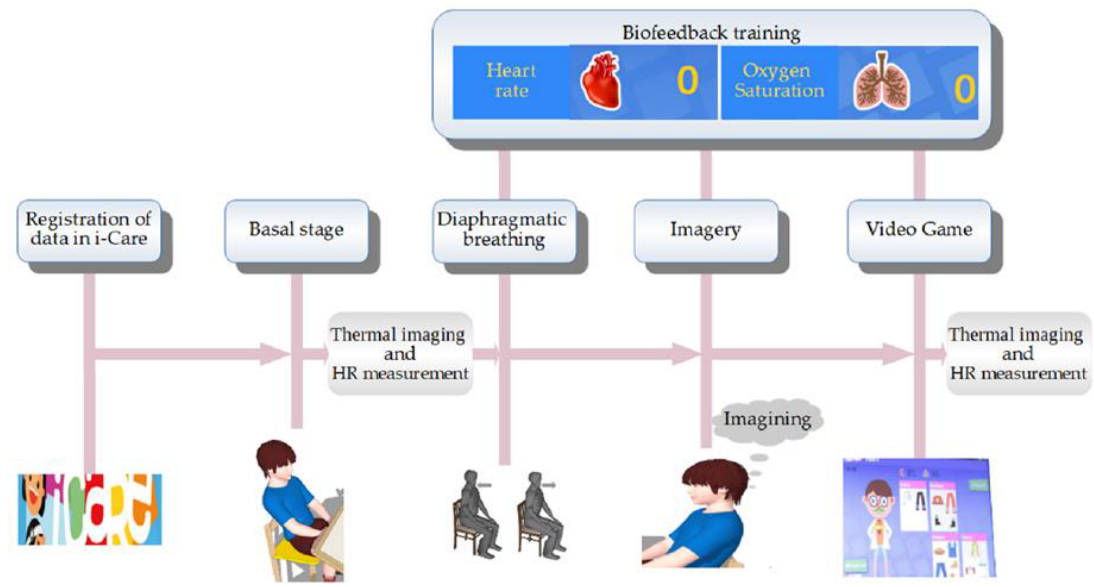
Figure 4. i-CARE protocol.